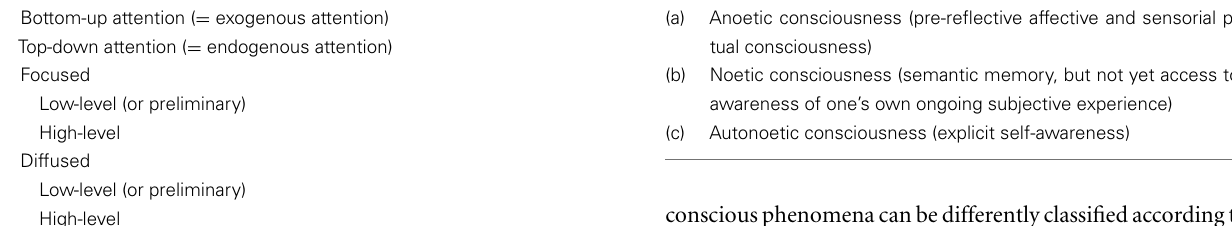
Table 1 |A categorization of top-down and bottom-up attention. Table 2 |A classification of